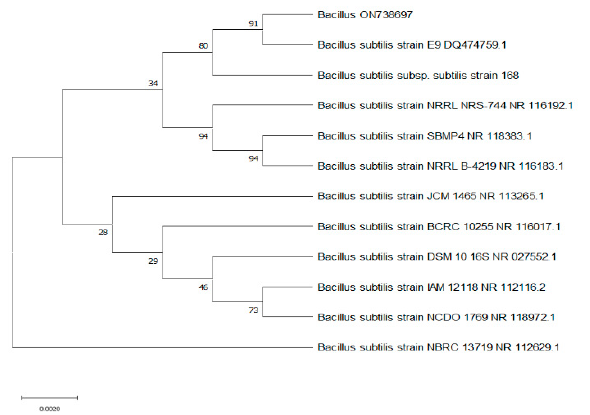
Figure 3. Phylogenetic tree showing evolutionary relationship based on the 16S rRNA sequences alignment among the isolated Bacillus strain GenBank accession ON738697 with the other related Bacillus subtilis strains: Bacillus subtilis subsp. subtilis strain 168 16S (NR_102783.2); Bacillus subtilis strain DSM 10 (NR_027552.1); Bacillus subtilis strain JCM 1465 (NR_113265.1); Bacillus subtilis strain NBRC 13719 (NR_112629.1); Bacillus subtilis strain IAM 12118 (NR_112116.2); Bacillus subtilis strain BCRC 10255 (NR_116017.1); Bacillus subtilis strain SBMP4 (NR_118383.1); Bacillus subtilis strain NCDO 1769 (NR_118972.1); Bacillus subtilis strain NRRL NRS-744 (NR_116192.1); Bacillus subtilis strain NRRL B-4219 (NR_116183.1); Bacillus subtilis strain E9 (DQ474759.1).